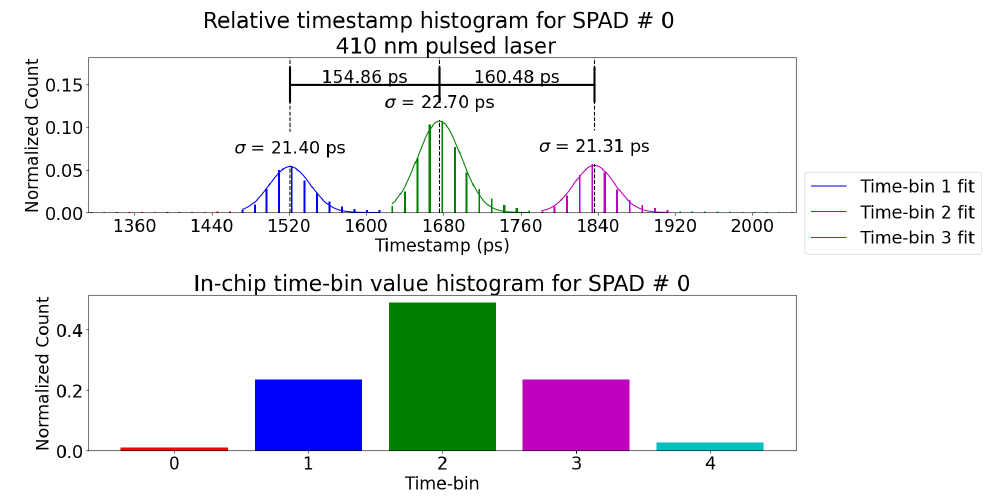
Figure 16. Time-bin histogram with on-chip timestamping and time-bin categorization. In this case, light was focused on SPAD #0 (connected to TDC #0) to compare the jitter with the previous results. The jitter increases from 10.48 ps to 22.7 ps RMS because the detection chain now includes the SPADs. Each event was categorized into a time-bin (0 to 4), which have programmable boundaries. The bottom histogram shows how many events were categorized in each bin, and the colors match bins between both graphs. Both histograms present the same information, either as relative time of detection or as on-chip categorized time-bins. Because the timestamps are relative to the end of the gating window, the late–late bin is #1, and the early–early is #3. The window size was set to 2.5 ns wide. The histograms are normalized so the total sum is